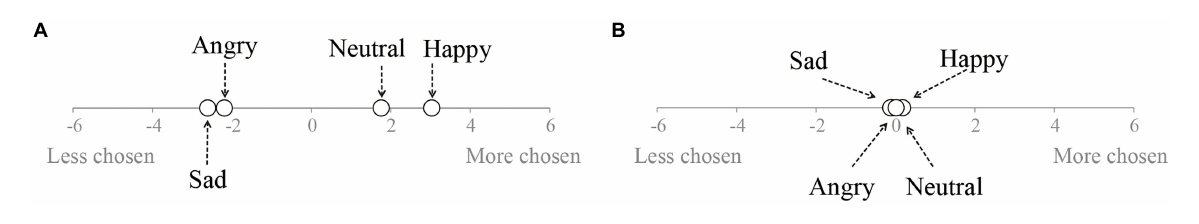
FIGURE 3 Results of experiment 2: Who is more trustworthy? Mean of the grade on the scale in trustworthiness judgments with 500 ms presentation (A) and 5 s presentation (B) .